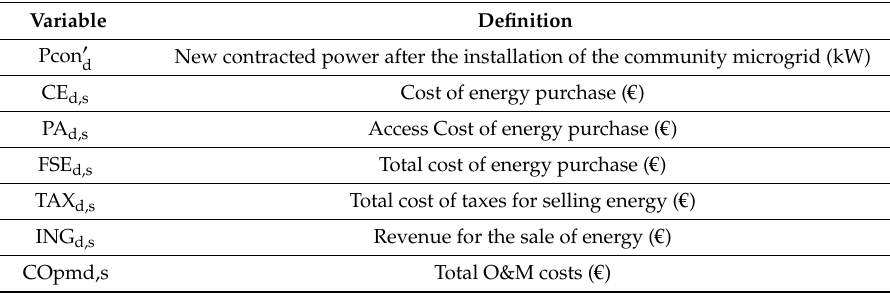
Table 10. Variables related to economic